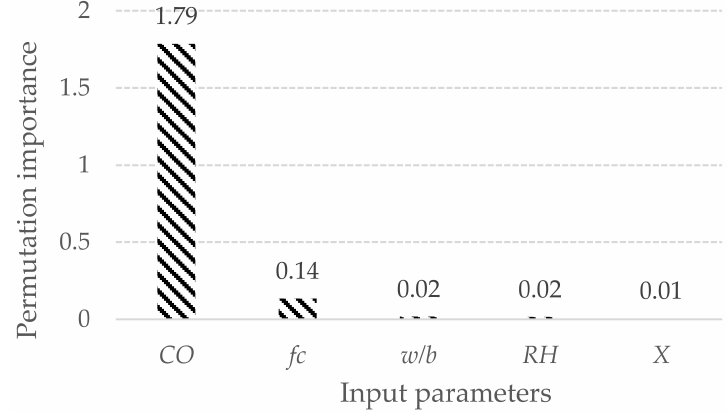
Figure 5. Permutation importance of RF model parameters.